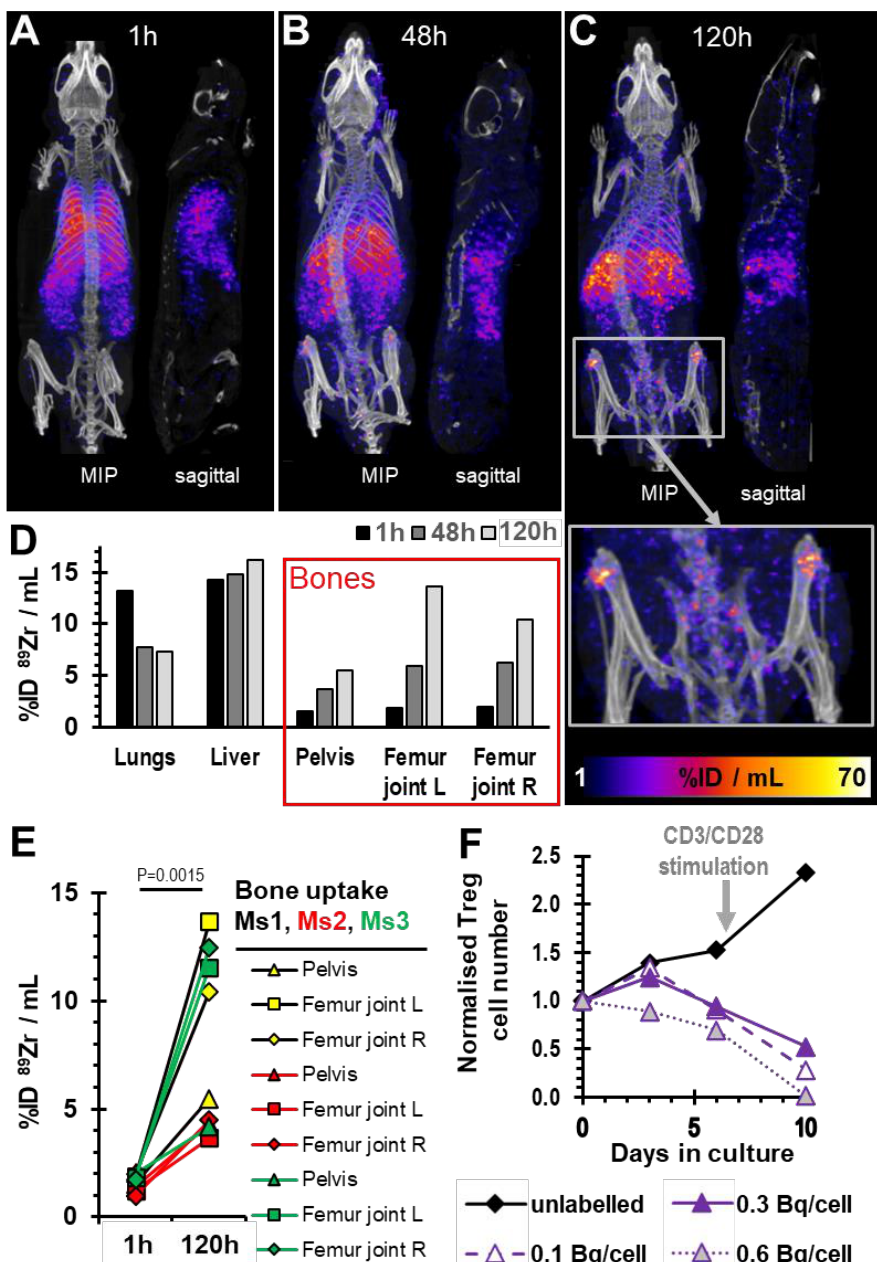
Figure 5. In vivo imaging of 89 Zr-Tregs. ( A – C ) PET/CT overlay images of a representative BRG mouse that had received HLA-A2-negative 89 Zr-Tregs (0.1 Bq/cell; 5 × 10 6 ; 0.7 MBq total radioactivity administered) with HLA-A2-positive Teffs admixed (5 × 10 6 ). Time points refer to the time passed after adoptive cell transfer. Maximum intensity projection images and sagittal sections of one of n = 3 mice are shown. The images are from the same mouse across ( A – C ). The inset in ( C ) shows 2-fold zoom of the pelvic area, clearly visualizing widespread and strong PET signals in various bones. ( D ) Quantitative ROI analysis of relevant tissues from the representative mouse shown in ( A – C ). ( E ) Comparison of three bone areas across three different mice imaged 1 h or 120 h after adoptive cell transfer. P -value calculated using two-tailed t -test (paired for each bone type in each mouse). n = 3 mice were used in this experiment and three different bone types analyzed per mouse. ( F ) The same 89 Zr-Treg batch that was administered to mice was also analyzed in vitro for its expansion capability (solid line). Controls were unlabelled (black) and higher labelled (dashed, dotted lines) Tregs from the same donor. Immediately after day 6, all cultures were re-stimulated with CD3/CD28 beads